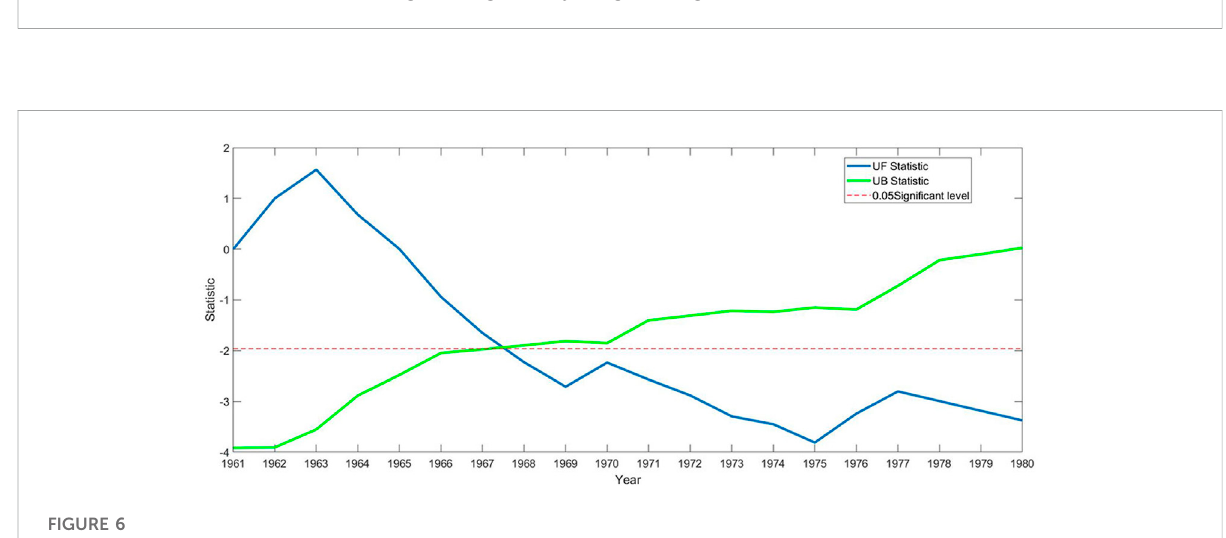
FIGURE 5 The Number of months of annual meteorological drought and hydrological drought from 1961 to 2016 on a 12-month time scale.